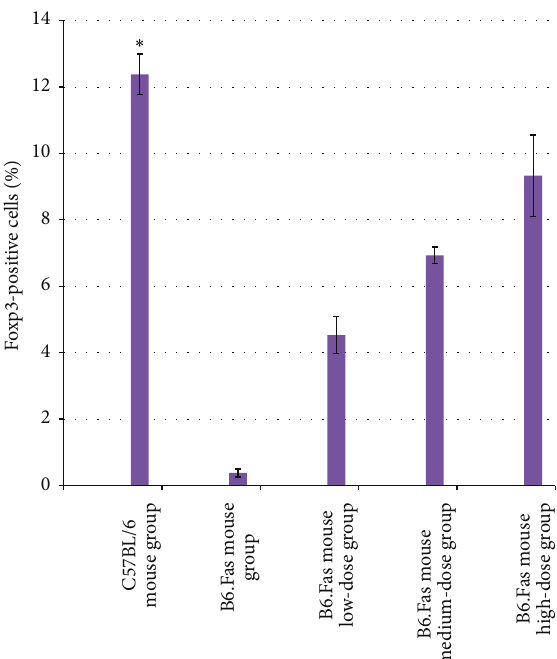
Figure 6: Percentages of Foxp3-positive cells in the five groups. The percentage of Foxp3-positive cells significantly decreased in the B6.Fas mouse model group compared with that of the C57BL/6 mouse normal control group. After treatment, the percentages of Foxp3-positive cells increased in the low-, medium-, and high-dose groups. The data are expressed as the mean ± standard deviation ( 𝑛 = 10 ). ∗ 𝑃 < 0.01 compared to other